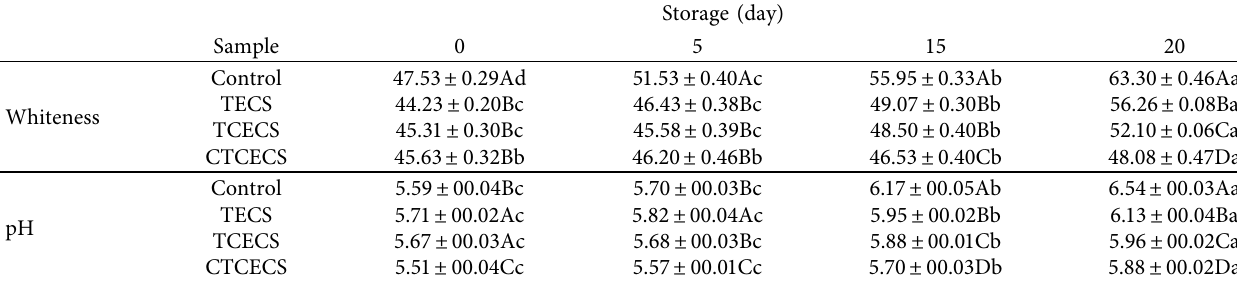
Table 4: Changes in whiteness and pH values of rainbow trout fillets during storage at 4 ± 1 ° C.